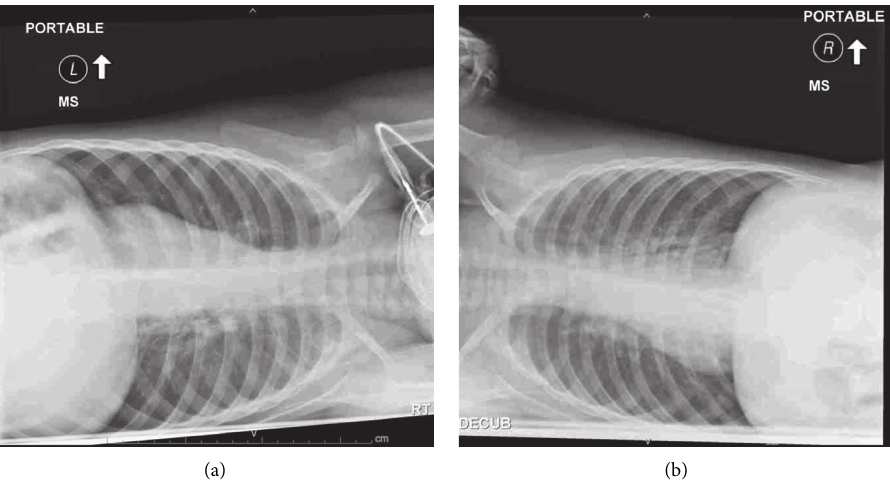
Figure 3: (a) Right and (b) left lateral decubitus chest X-rays taken after the EITdevice was used in attempt to confirm diagnosis of FBA by more traditional means. The attending pediatric radiologist read these images: “Both lungs are hyperinflated on the decubitus view without significant asymmetry which suggests air trapping secondary to bronchiolitis.”